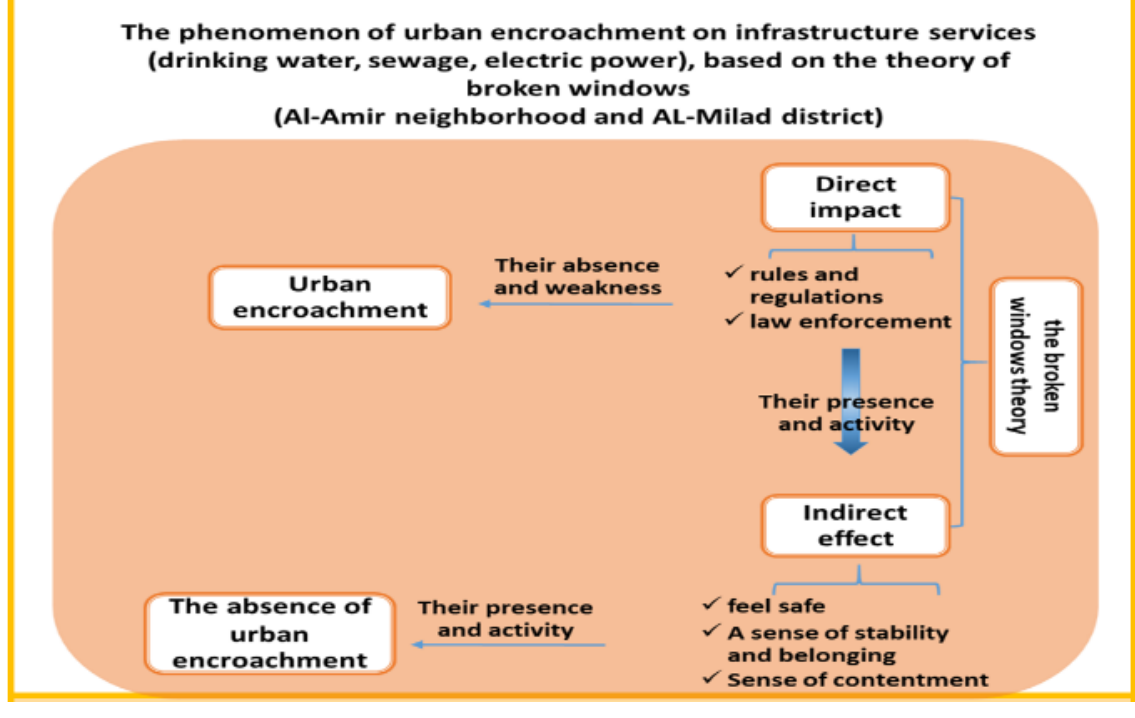
Fig. 4. The phenomenon of urban encroachment on infrastructure services based on the theory of broken windows, source: the researcher based on the experiments at the study